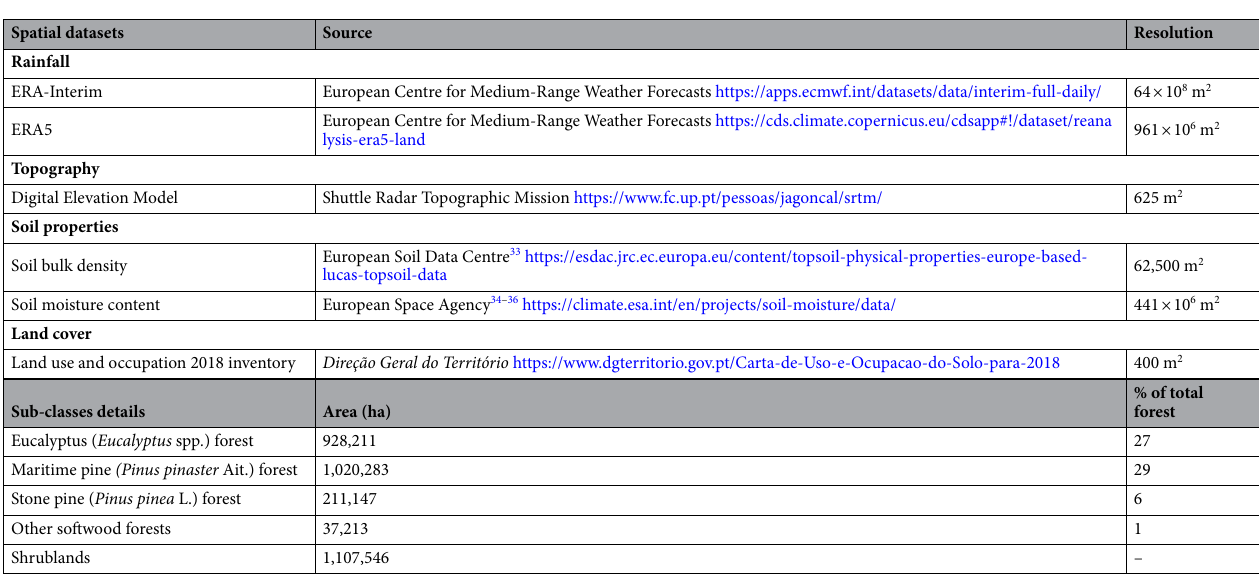
Table 1. Spatial datasets used, source of data and original